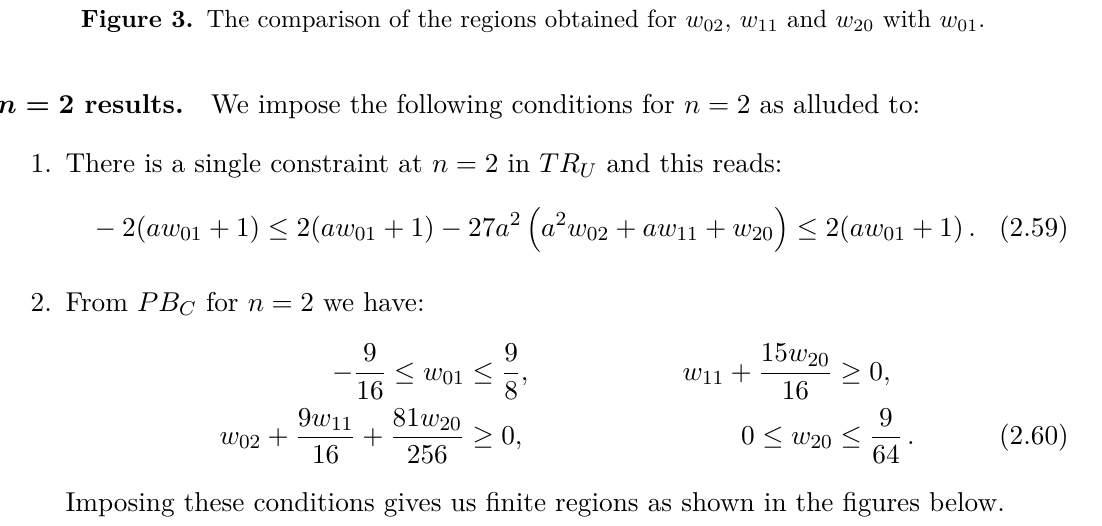
Figure 3. The comparison of the regions obtained for w 02 , w 11 and w 20 with w 01 .